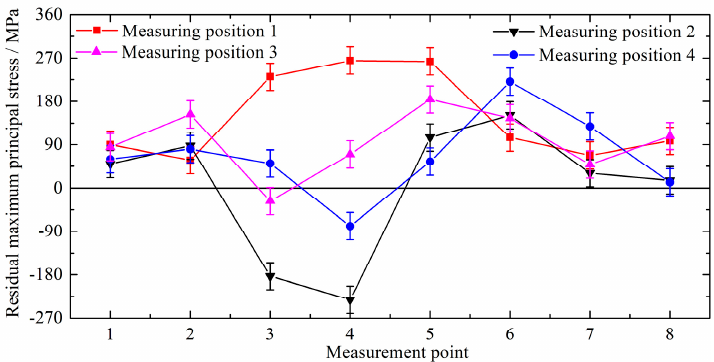
Figure 3. Measurement results of residual maximum principal stress of large ring ‐ rolling.